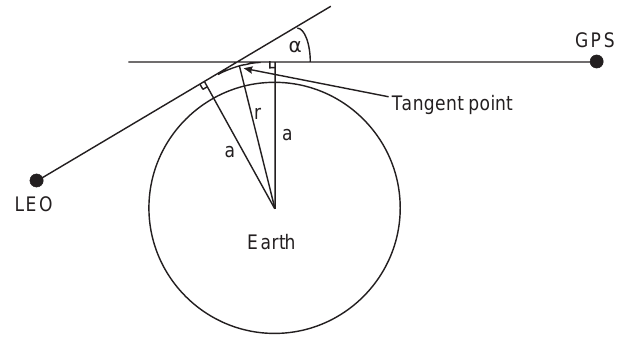
Fig. 1. GPS–LEO occultation geometry defining the atmospheric bending angle a , the impact parameter a , and the radius to the ray tangent point (ray perigee),